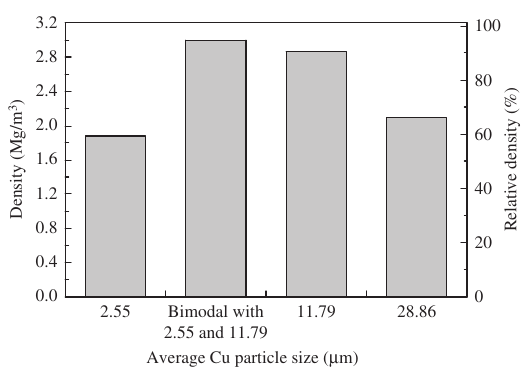
Figure 6 Effect of the added Cu particle sizes on the density of CF/Al